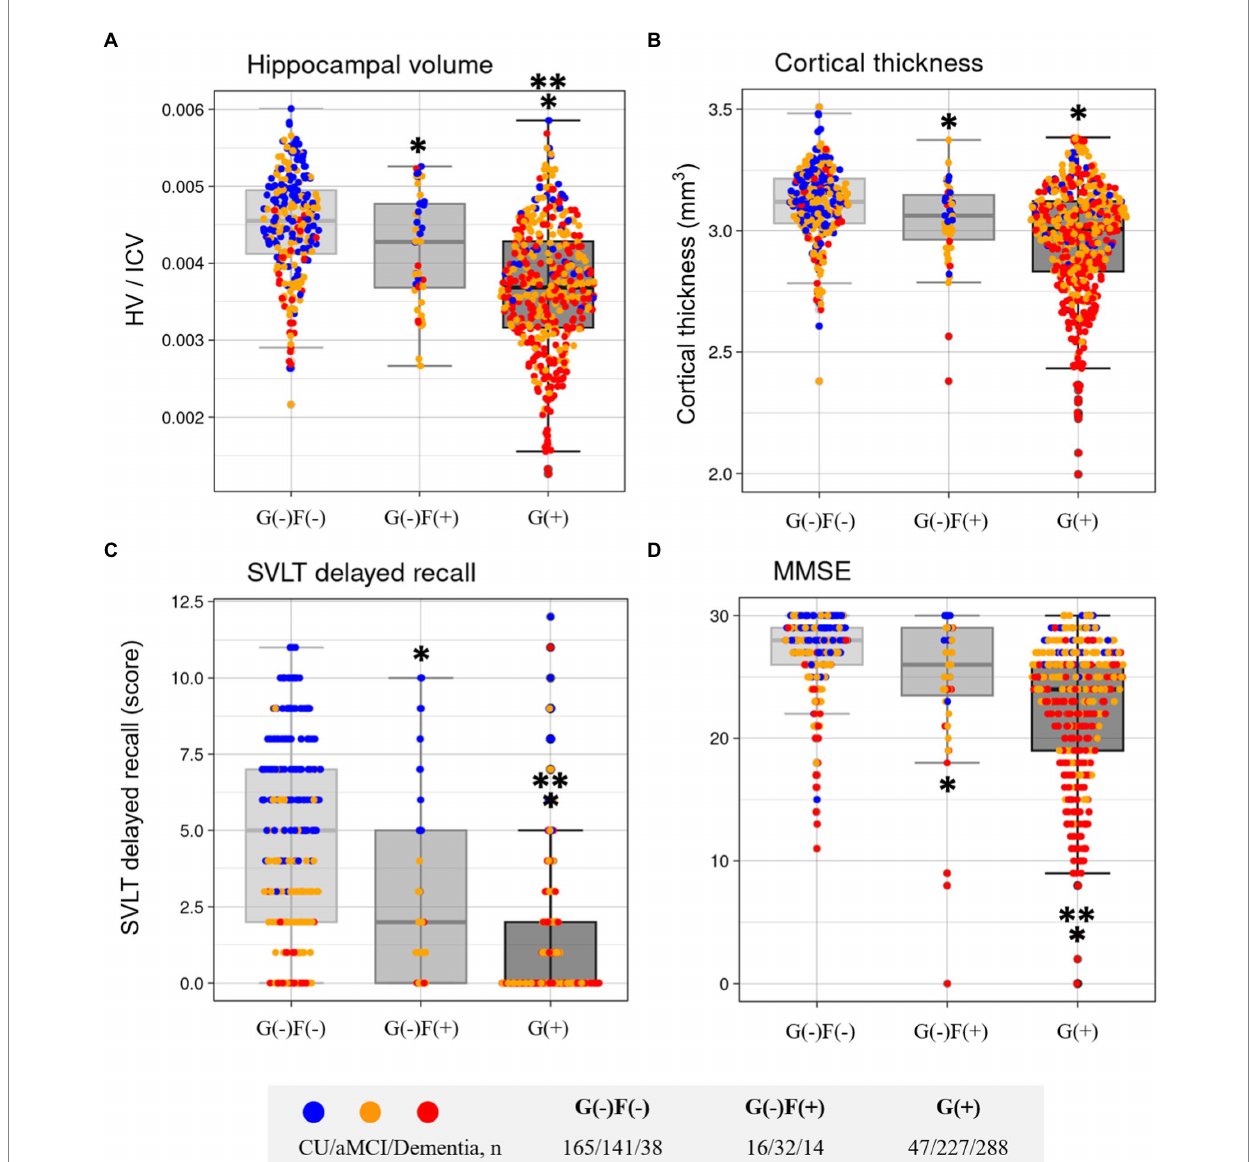
FIGURE 5 Comparisons of characteristics according to group in Hippocampal volume (A) , Cortical thickness (B) , SVLT delayed recall (C) , and MMSE (D) . F, focal type amyloid accumulation; G, global standardized uptake value ratio; HV, Hippocampal volume; ICV, intracranial volume; W, whole region type amyloid accumulation; SVLT, Seoul Verbal Learning Test-Elderly’s version; MMSE, Mini-Mental State Examination. * p < 0.05 group vs. G( − )F( − ). ** p < 0.05 group vs. G( −